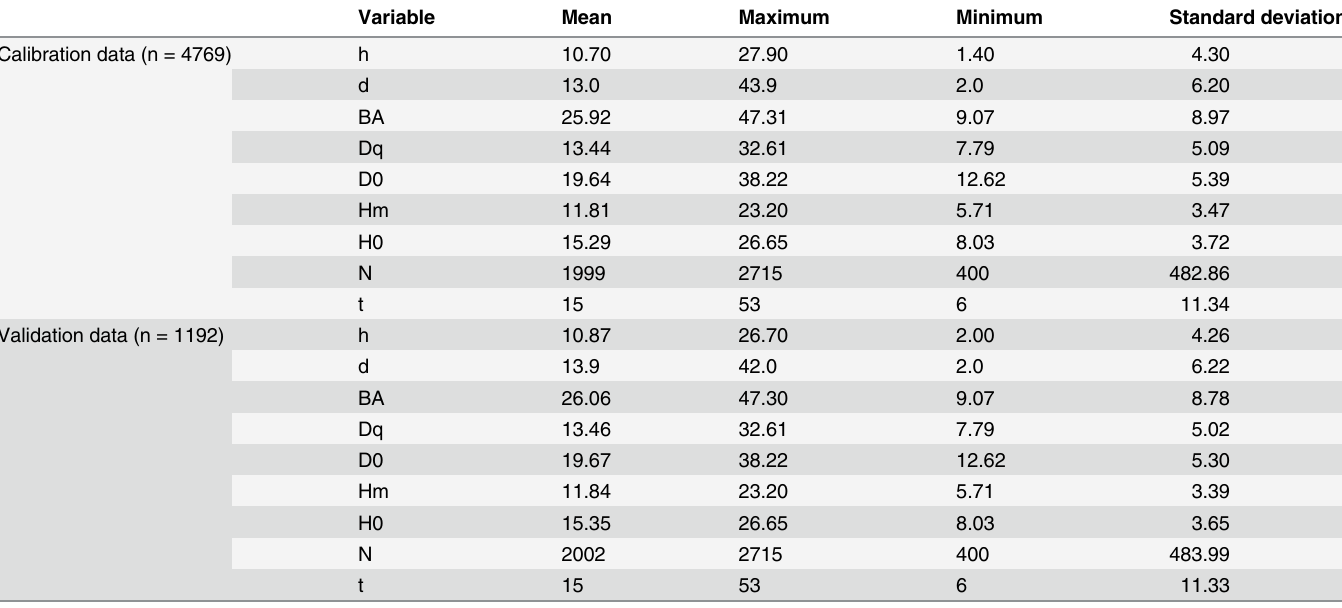
Table 1. Descriptive statistics of the sample trees in the plots of Chinese-fir.